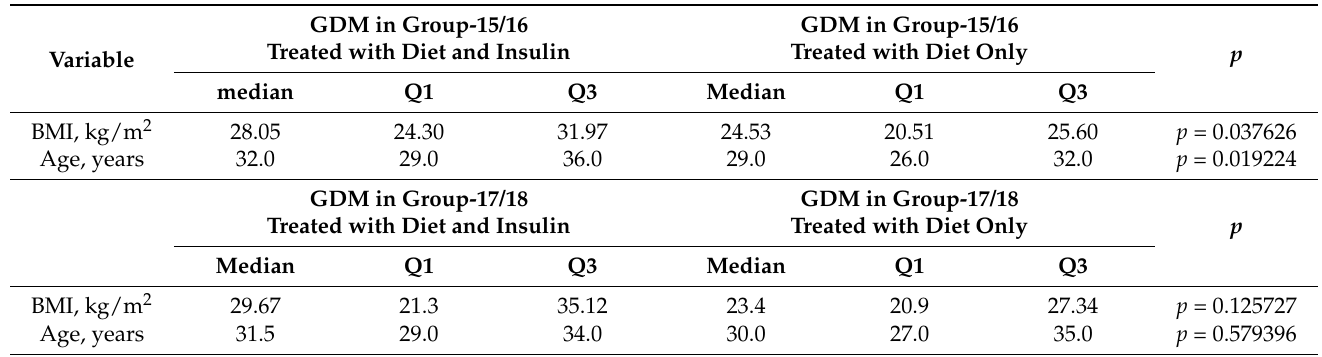
Table 6. The relationship between the mode of treatment and the age of patients and body mass index (BMI) values.